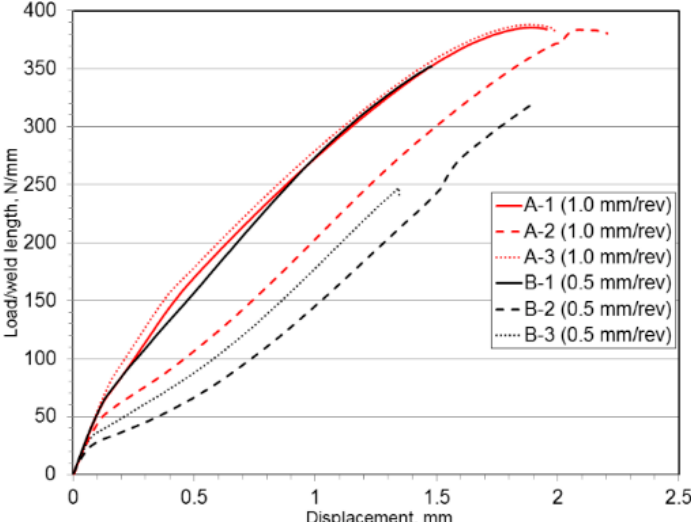
Figure 18. Lap shear curves at the different revolutionary pitch, joint strength expressed as the maximum failure load per millimeter of the weld.